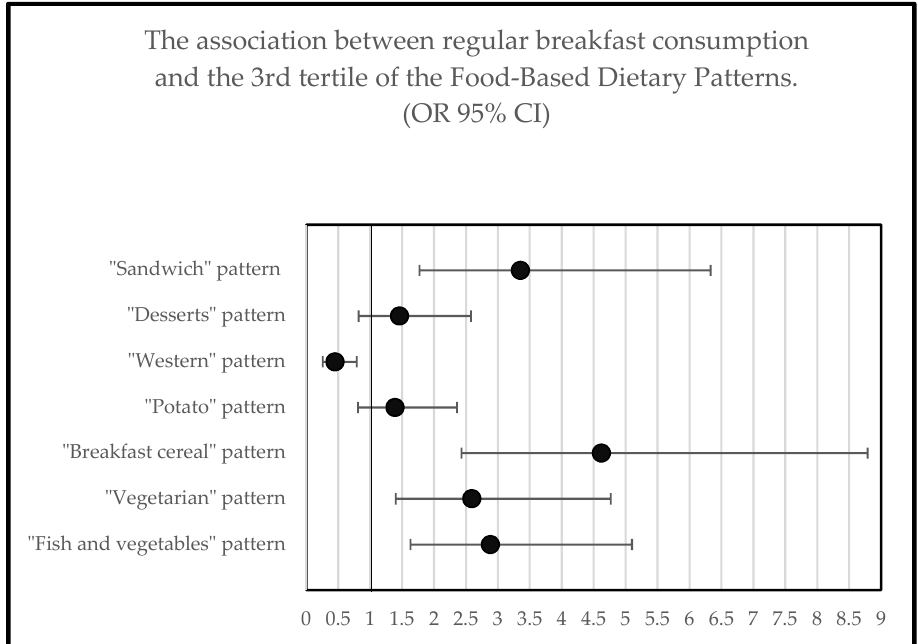
Figure 1. The association between regular breakfast consumption and the highest adherence to the